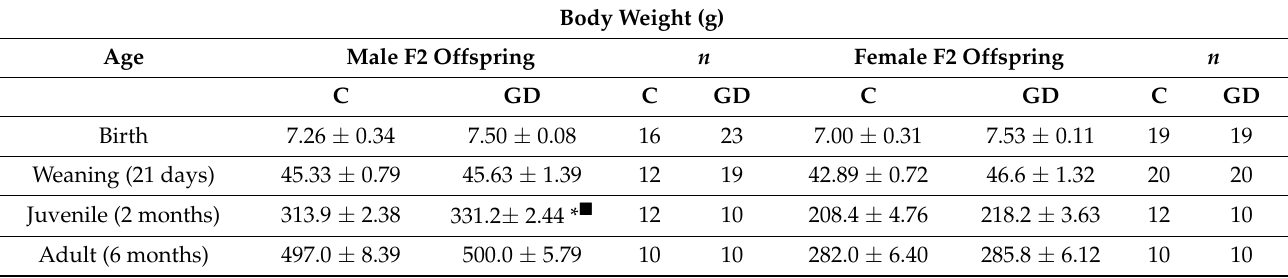
Table 1. Second-generation offspring body weight at different ages.